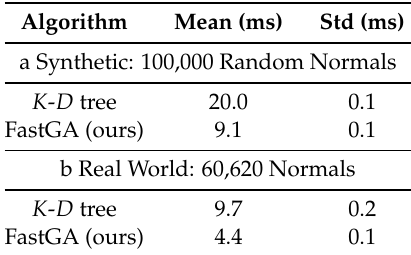
Table 2. Execution Time Comparisons for Synthetic and Real World Datasets